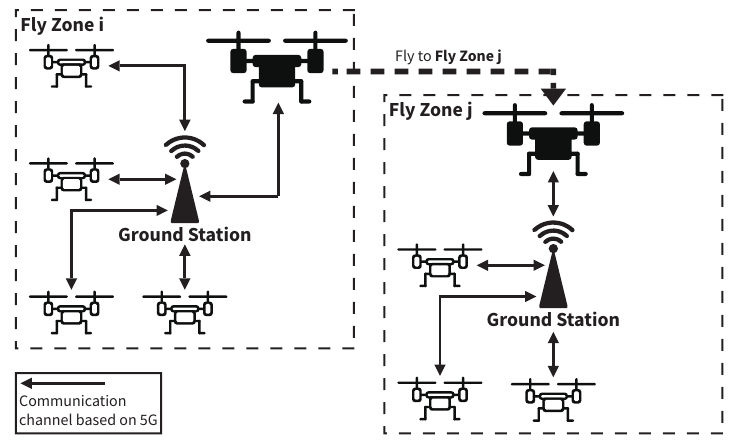
Figure 1. Communication channels between drones and ground stations in